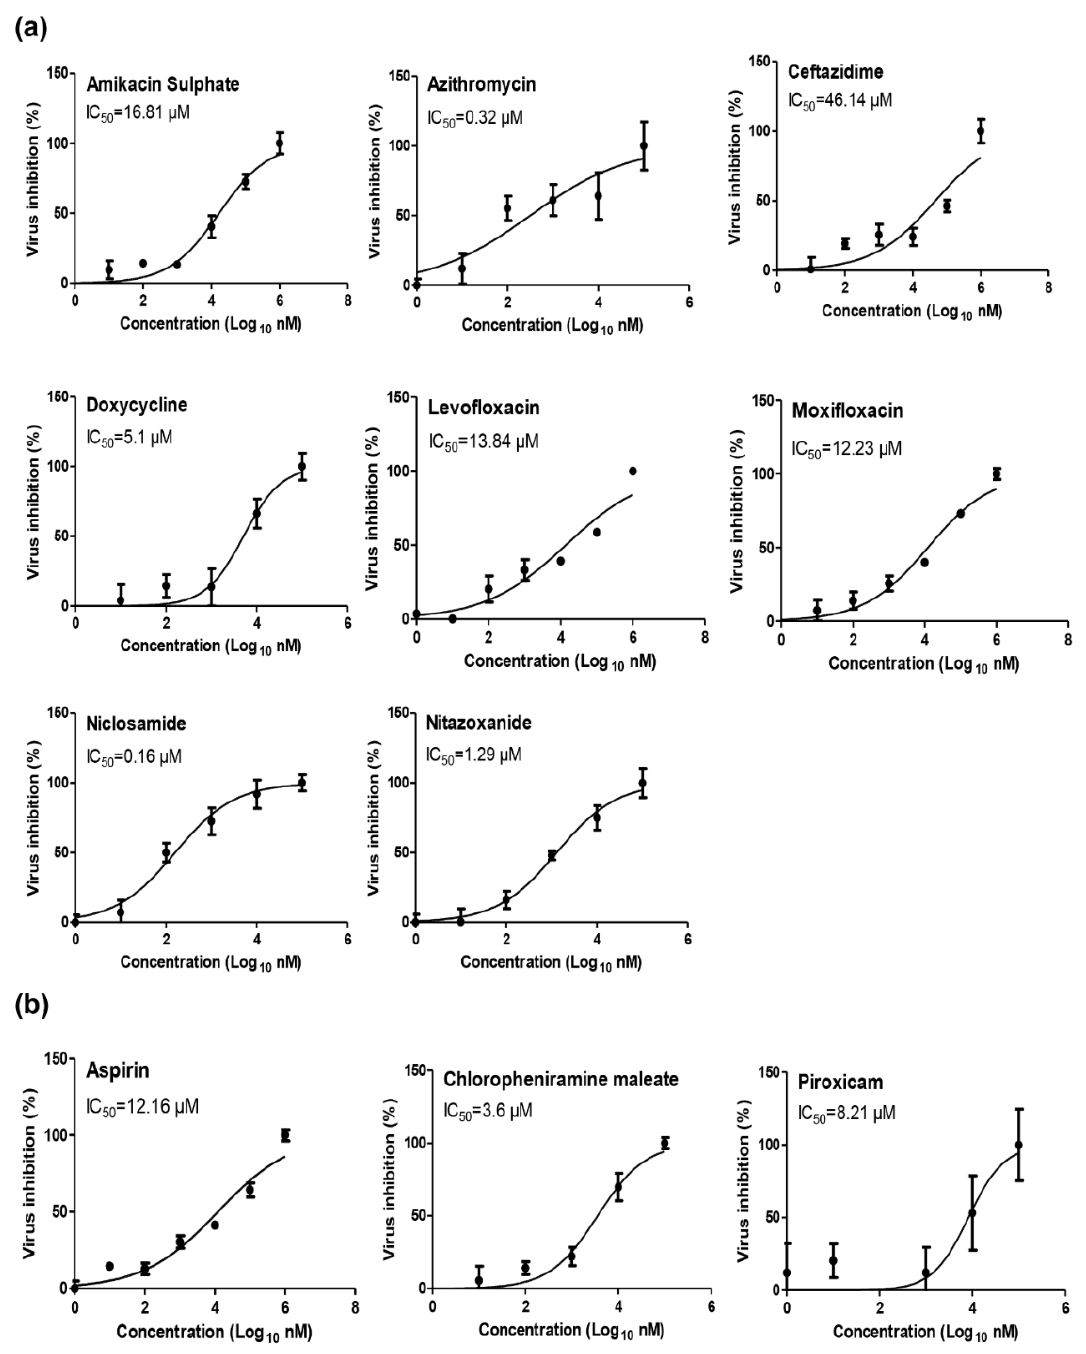
Figure 1. Dose-inhibition curves for anti-microbial and anti-inflammatory FDA-approved drugs with high selectivity indices against NRC-03-nhCoV. ( a ) Amikacin sulphate, Azithromycin, Ceftazidime, Doxycycline, Levofloxacin, Moxifloxacin, Niclosamide, and Nitazoxanide, ( b ) Aspirin, Chlorpheniramine maleate, and Piroxicam. Inhibitory concentration 50% (IC 50 ) values were calculated using nonlinear regression analysis of GraphPad Prism software (version 5.01) by plotting log inhibitor versus normalized response (variable slope).